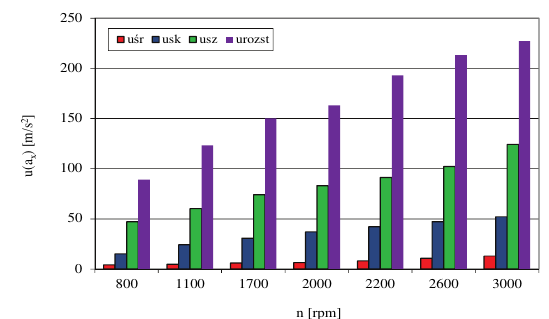
Fig. 4. Mean, RMS, peak and peak-to-peak value of vibration accelerations for X dimension and different engine speeds